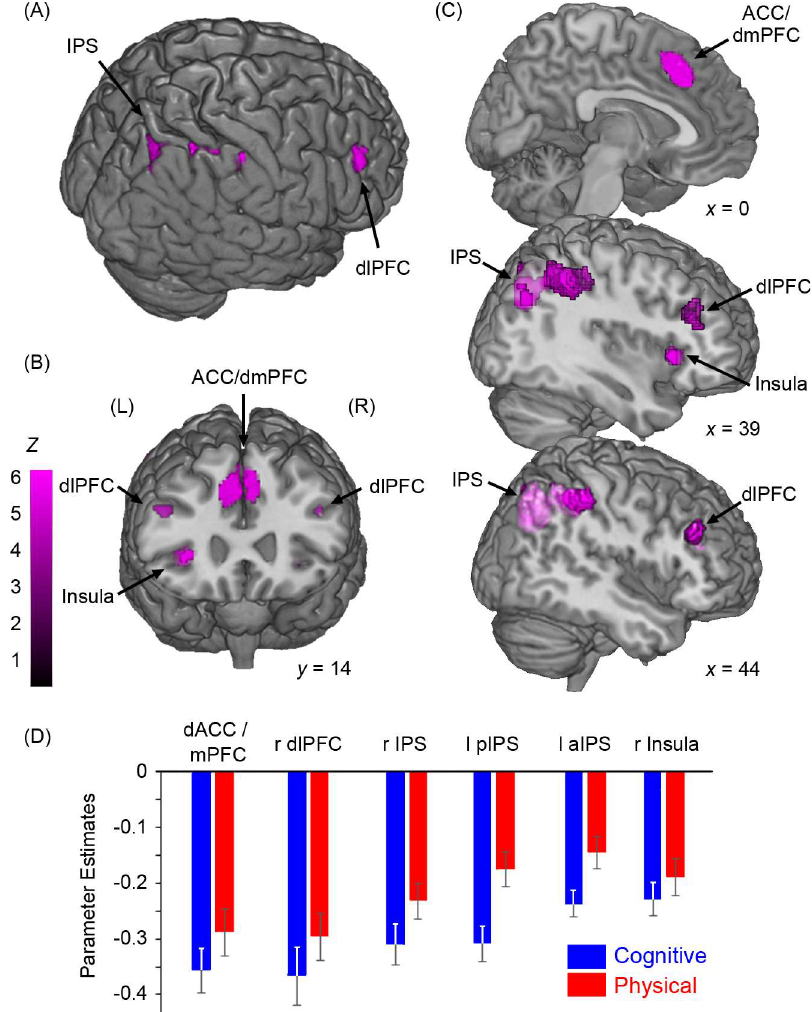
Fig 4. A network of domain-general areas was involved in the valuation of cognitive and physical effort. Conjunctionanalysesdemonstrated that the activity of these areas covariedwith SV parameters, independent of the type of effort cost. (A) Whole-brain render, showingfoci in the right intraparietal sulcus (IPS) and the right dorsolateral prefrontalcortex (dlPFC), comprisingthe middle frontal gyrus (MFG) and adjacent inferior frontal sulcus (IFS). (B) Coronalsection showingactivity in the anterior cingulatecortex (ACC) and adjacent dorsomedial prefrontal cortex (dmPFC), IFS, and right insula. (C) Sagittal sections showingACC/dmPFC, IPS, and dlPFC activity. (D) Parameter estimates for domain-generalclusters. Underlying data for panel D can be found in S1